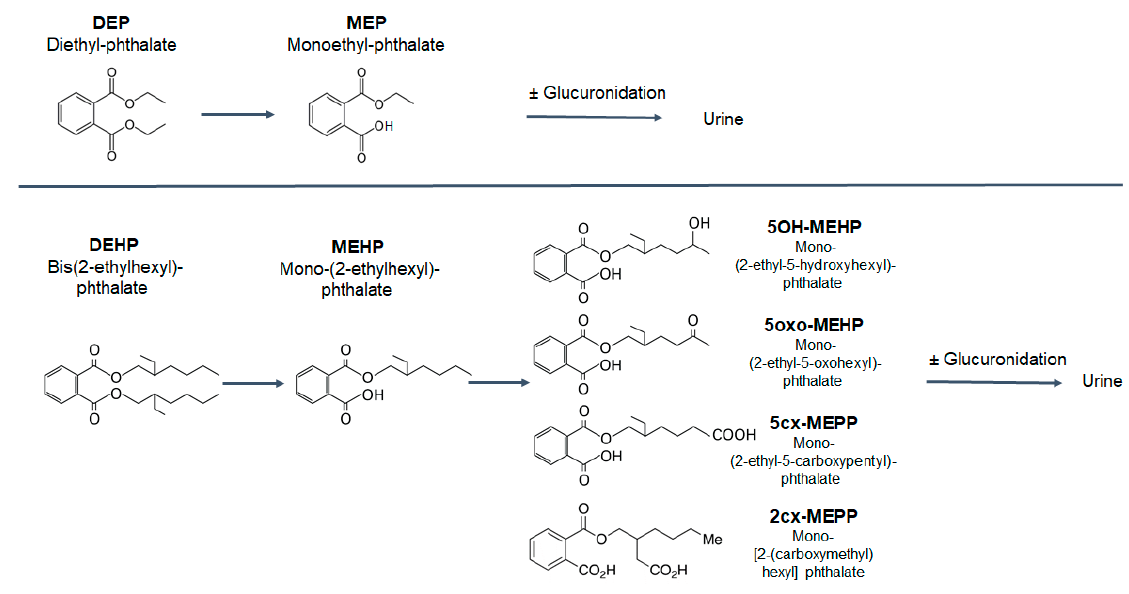
Figure 1. Analysed metabolites of diethyl phthalate (DEP) and bis(2-ethylhexyl) phthalate (DEHP) in this study, adapted from Koch et al. [23].